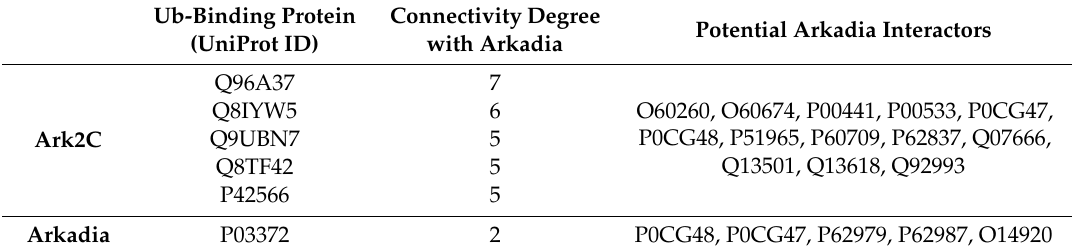
Table 2. Ub-binding proteins sharing the most common interactors (mentioned as connectivity degree) with Ark2C and Arkadia, respectively. The most frequently reccurring Ub-binding protein interactors constitute the putative Arkadia interactors. These were further refined, based on subcellular localization